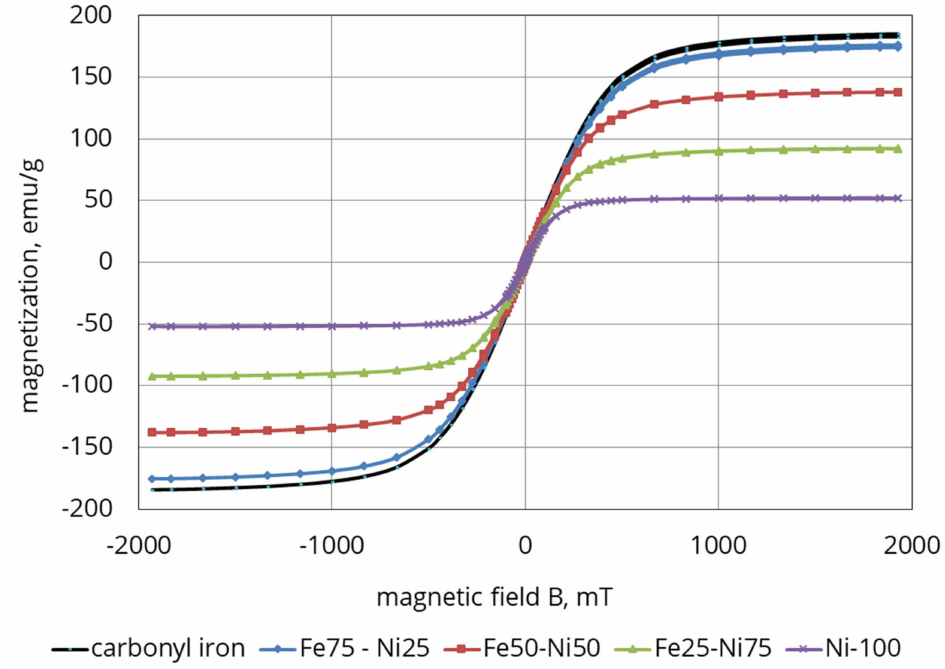
Figure 4. Magnetization curves of Fe–Ni systems with xFe = 0, 25, 50, 75, and 100